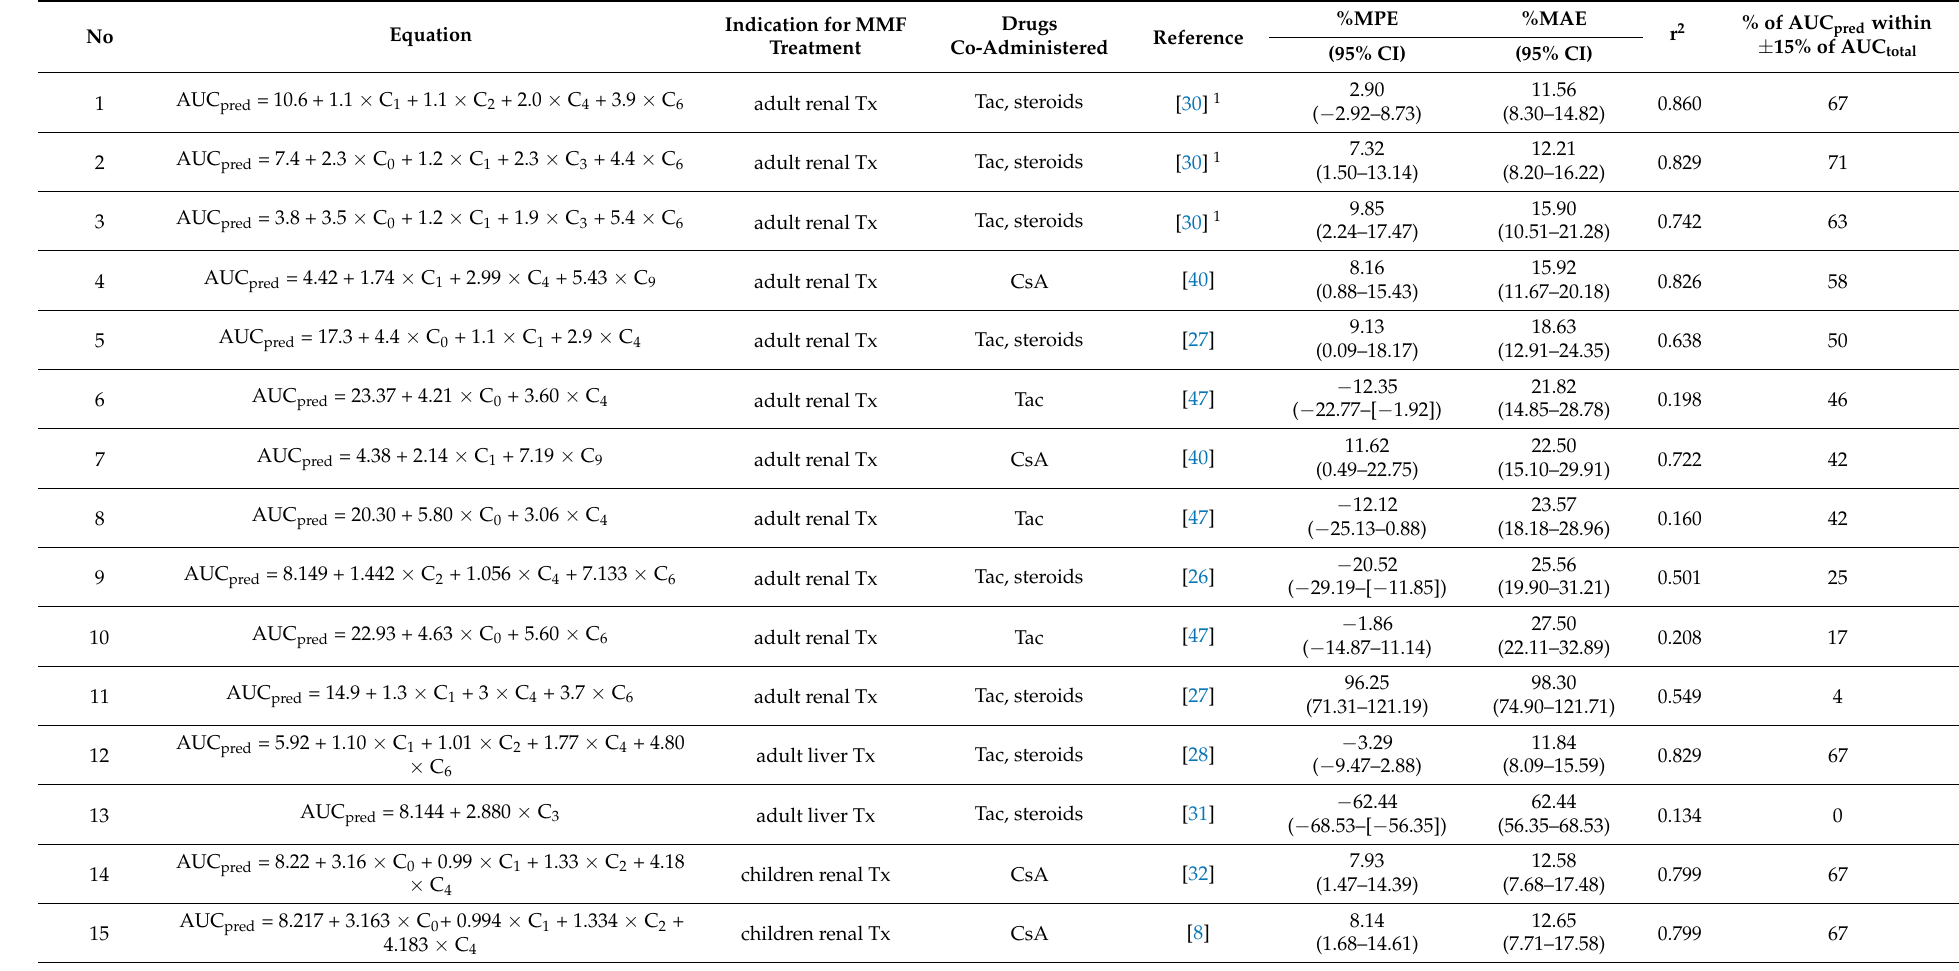
Table 3. The predictive performance of MLR-based EMIT/PETINIA-MPA LSSs available in the literature for estimation of MPA AUC pred in children with nephrotic syndrome treated with